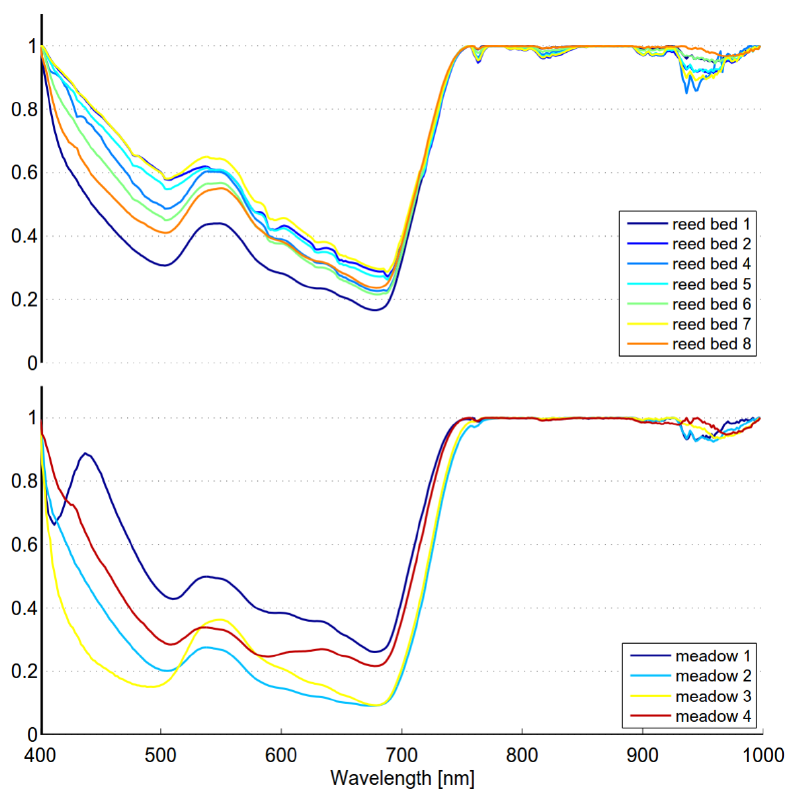
Figure 6. Continuum removed spectra of reed bed and meadow classes.